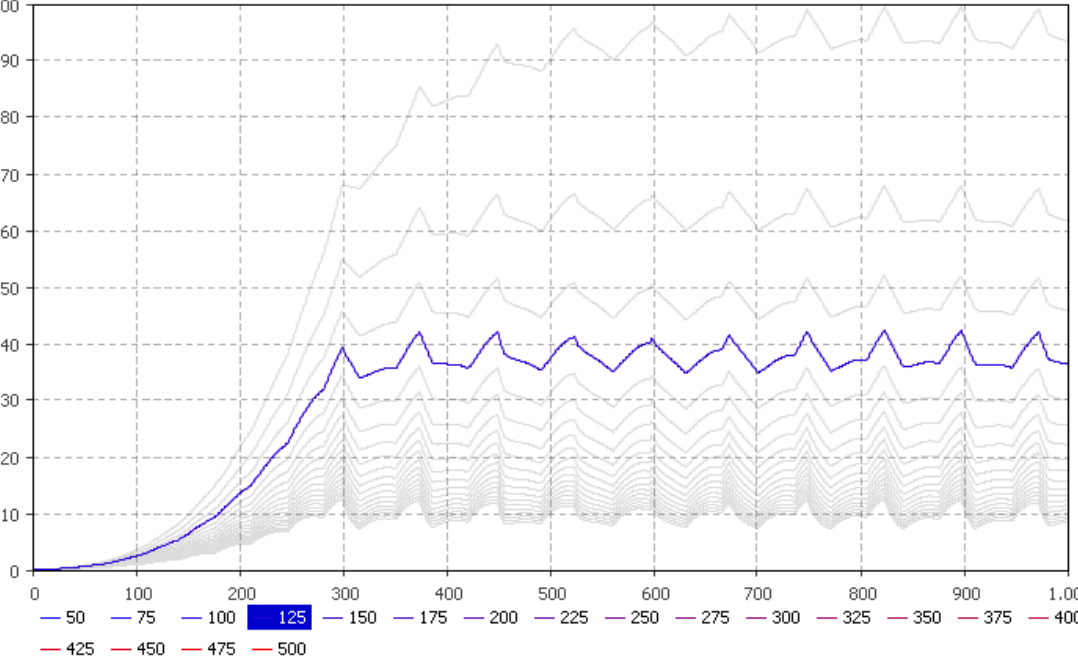
Figure 13. Parameter variation experiment for estimated N ‐ NO 3 concentration (in mg/L) when using different cultivation areas (in m 2 ) Compared to the exclusive use of natural light, the application of artificial light for industrial production shows a different picture. The y ‐ axis shows the RAS N ‐ NO 3 concentration, whereas the x ‐ axis displays the days.